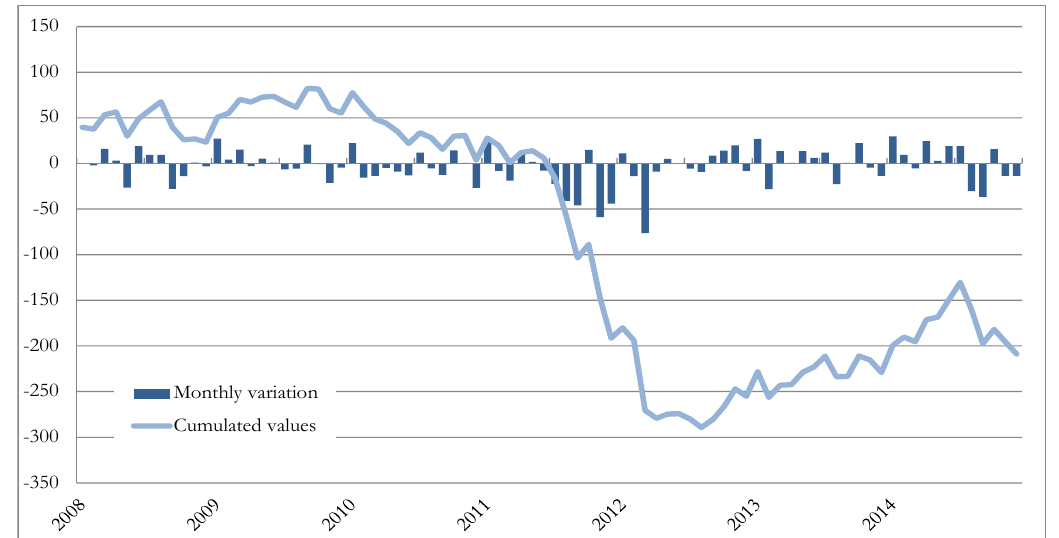
Figure 6. TARGET2 balances towards the Eurosystem, Italy (Euro billion, monthly, end of the period). Source: Elaboration on the “Institute of Empirical